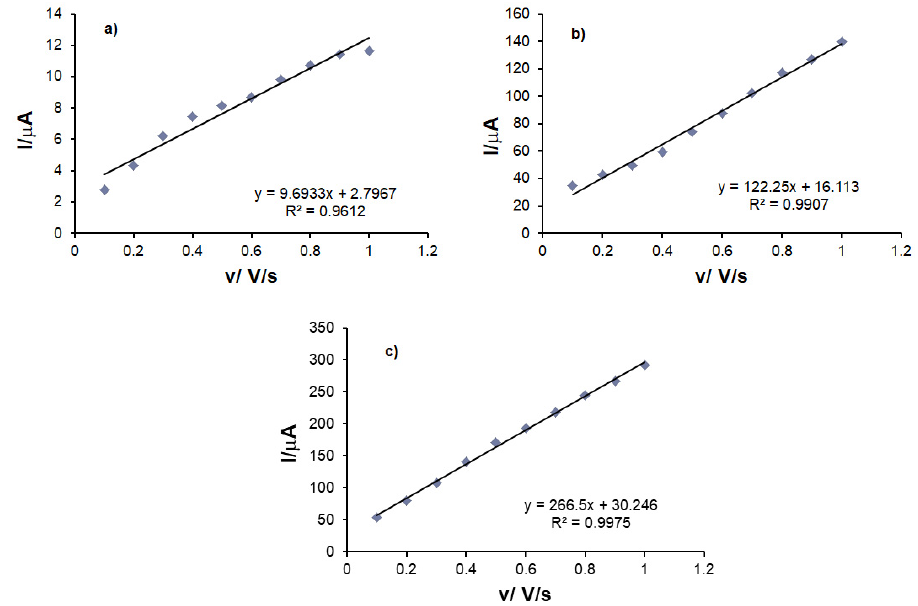
Figure 8. Linear dependence between anodic peak current and scan rate for ( a ) C-SPCE, ( b ) MC-SPCE, ( c ) OMC-SPCE.